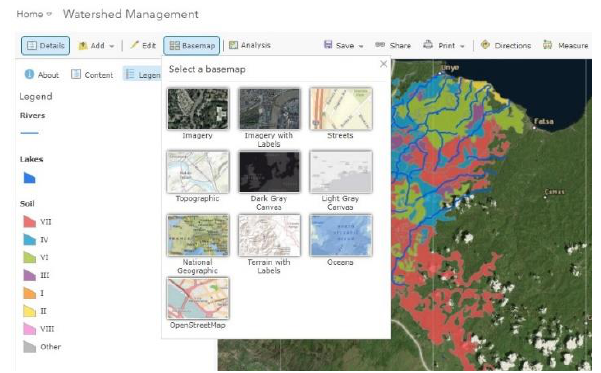
Figure 6: Basemap changing function of cloud